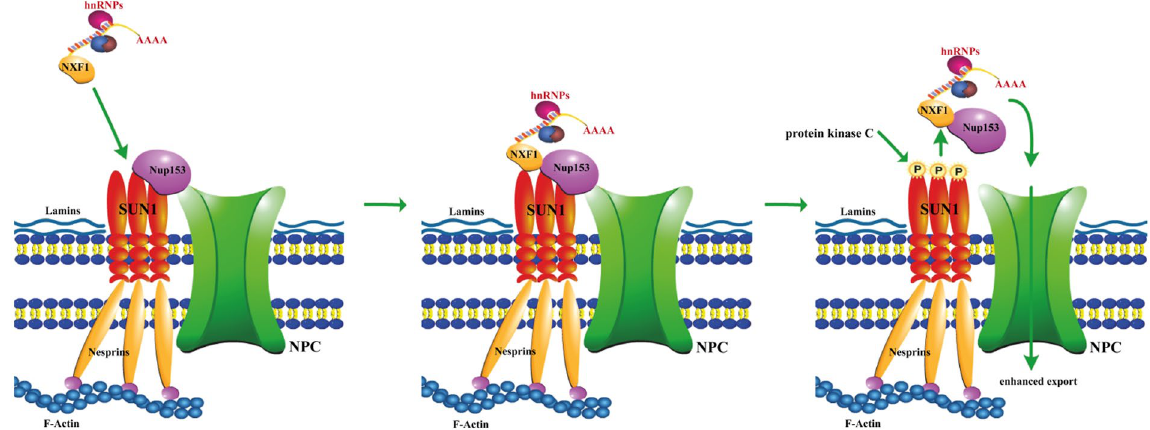
Figure 5. Model depicting the proposed role of SUN1 phosphorylation in mRNA export. SUN1 binds mRNP/ NXF1 complexes at the nuclear envelope (NE). Upon an unidentified signal, SUN1 is phosphorylated at S113 by a PKC. This reduces the NXF1 affinity and the complex then binds to NUP153 which is also associated with SUN1 at the NE. The mRNP is targeted to the nuclear pore and